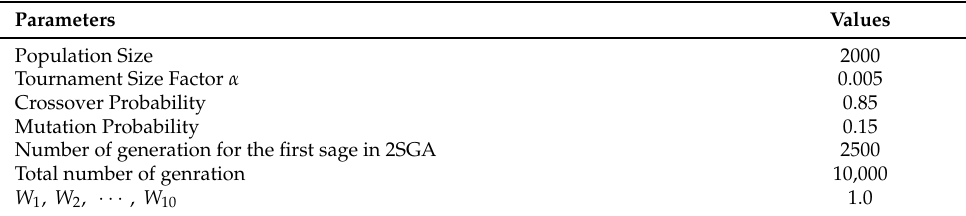
Table 15. Algorithm